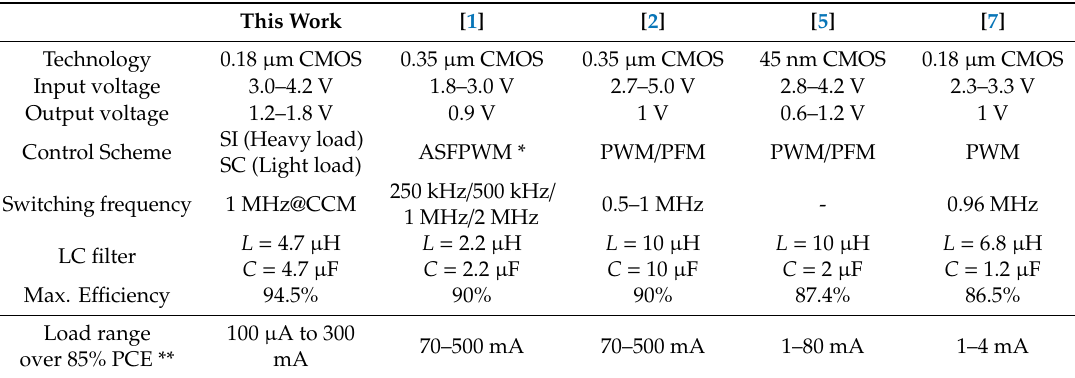
Figure 14. Measured e ffi ciency plot versus the load current with V DD = 3.7 V and V O = 1.8 V. Table 2. Performance comparison